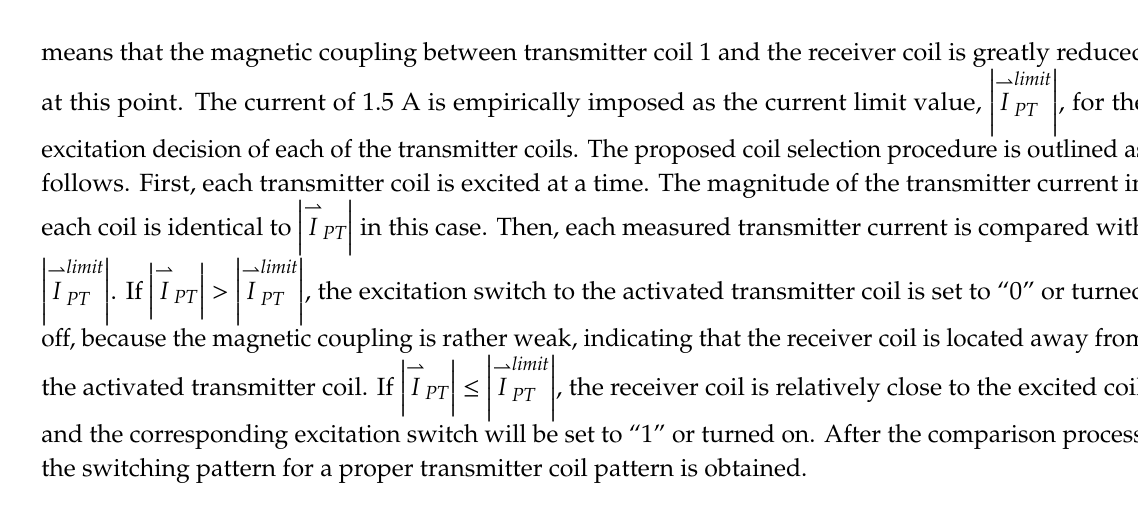
Table 1. Possible switching patterns of the inverter circuit with n = 4.